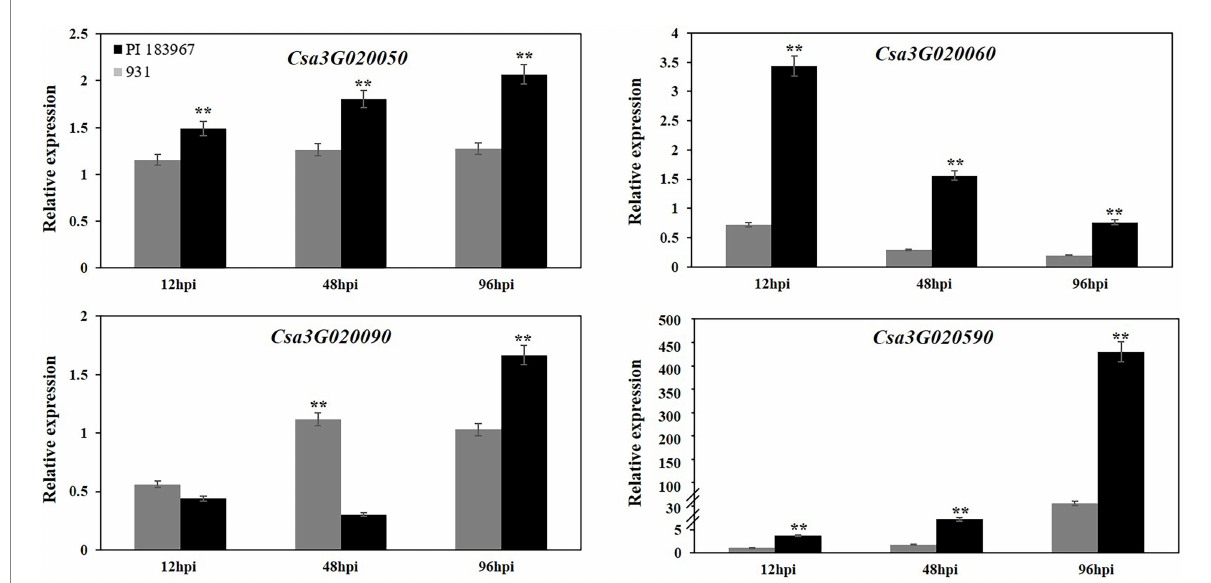
FIGURE 6 Relative expression levels of candidate genes in “PI 183967” and “931” after inoculation with at 12, 48, and 96 hpi. The Y-axis represents the relative expression level of candidate genes at 12, 48, and 96 hpi, compared with 0 hpi. Asterisks indicate significant differences as determined by ANOVA (** p <